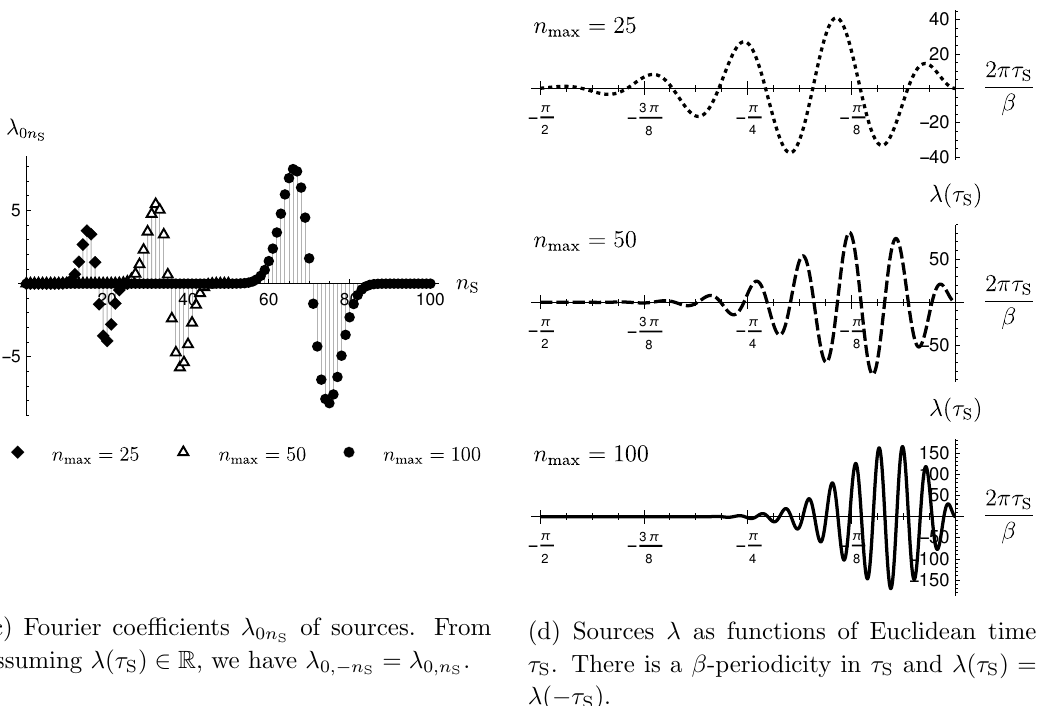
norms of initial (b) Initial data Φ (1) ( t S = 0 , σ S ) (plotted for σ S 0) and Φ (2) ( t S = 0 , σ S ≥ 0) on the two sides of the black hole. σ S ≤ The coloured curves correspond to n max = 2 , 3 , . . . , 10 and the black curves correspond to n max = 25 , 50 , 100.